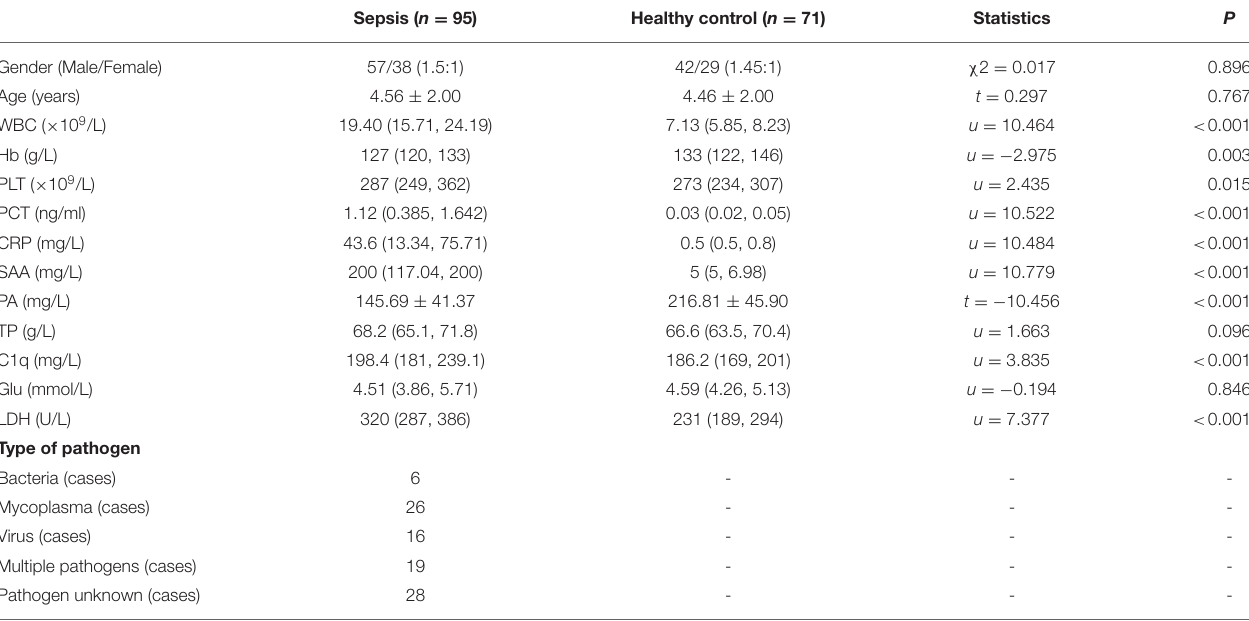
TABLE 1 | Clinical characteristics of the